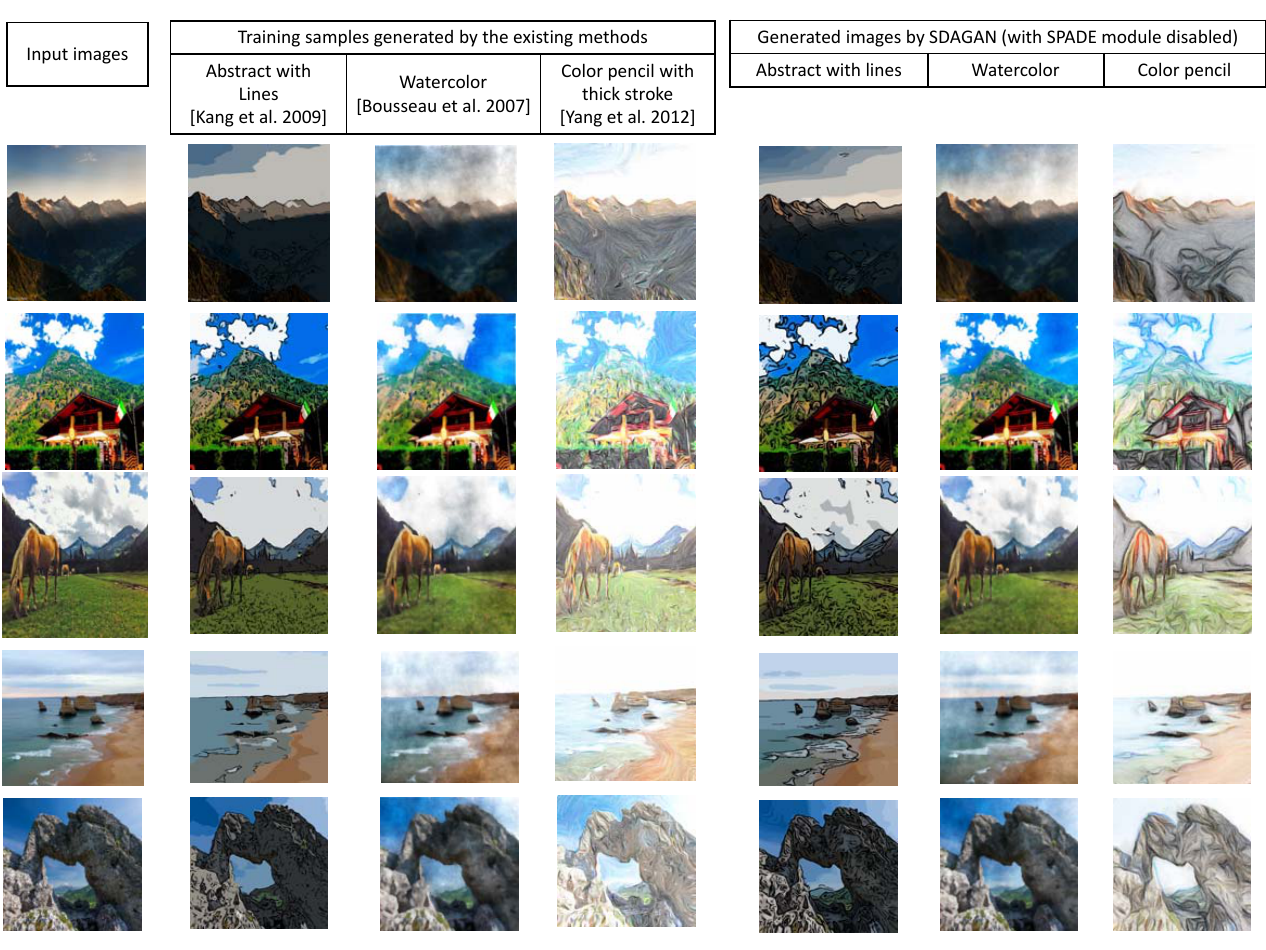
Figure 6. Our result images of single artistic style generated from our SDAGAN trained using the images generated from the existing methods. These images are generated using our SDAGAN where SPADE modules are